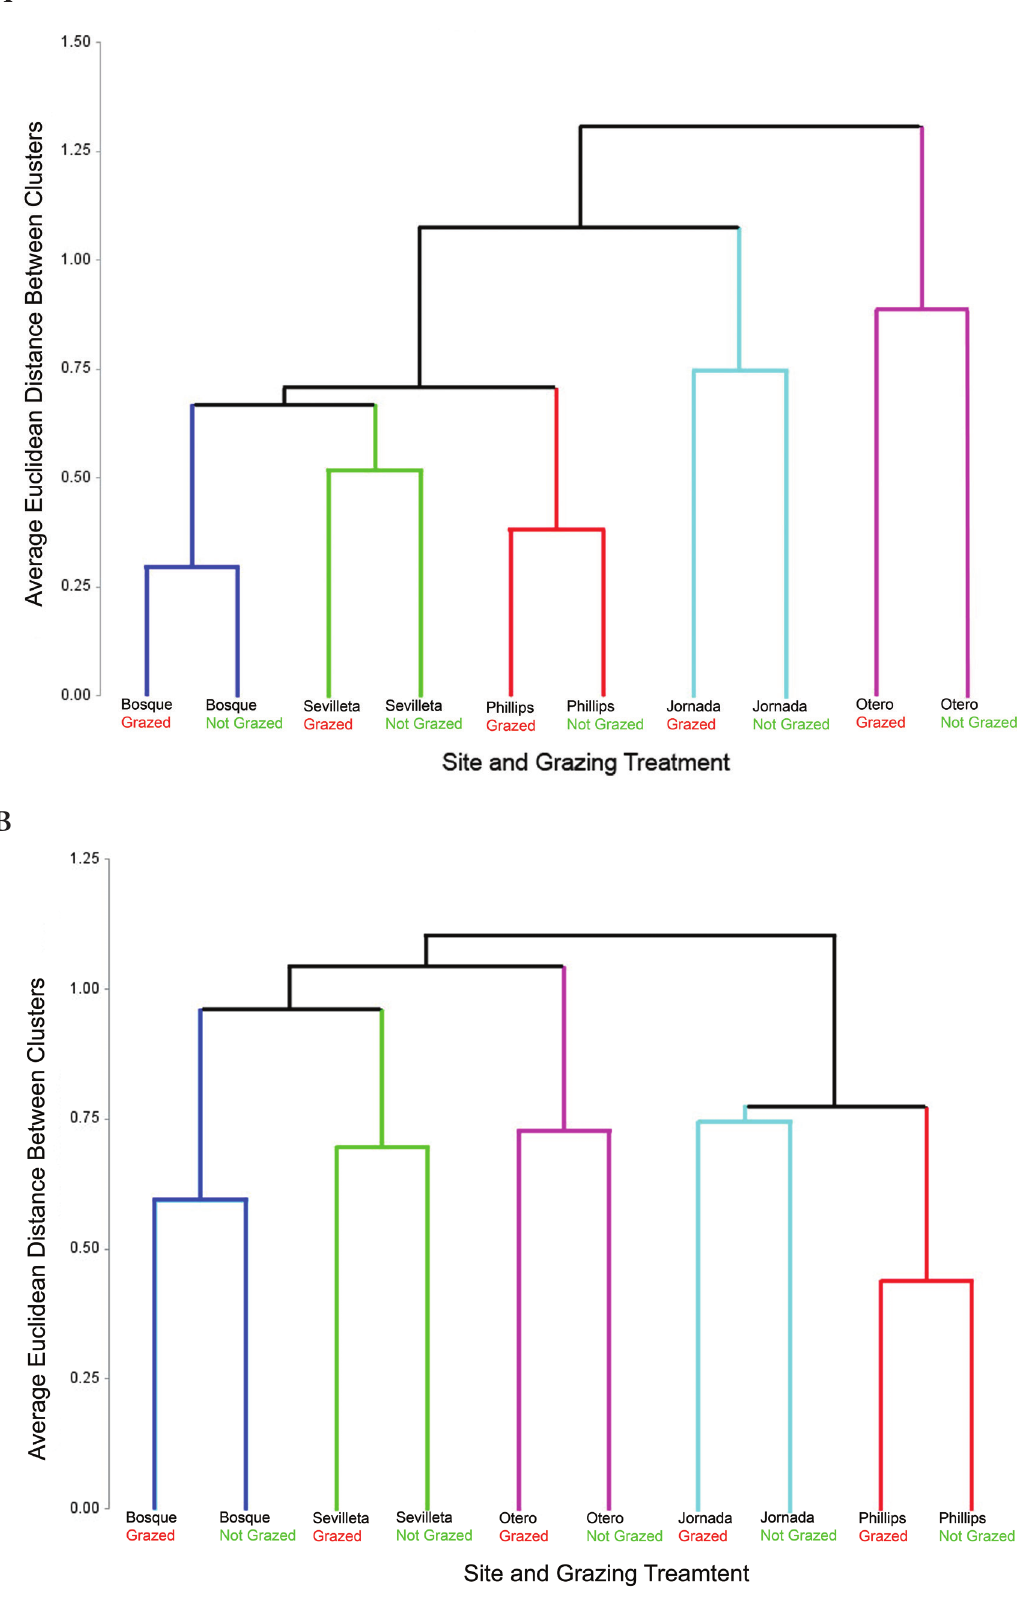
Fig. 3. Cluster analysis dendrogram showing the similarities of plant species compositions at sites and grazed and not grazed transects within sites, from annual canopy cover/m 2 averaged over all years and seasons; A. Spring; B.